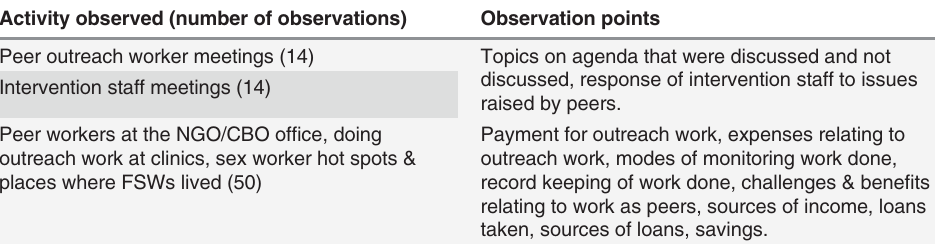
Table 1. Activities observed to understand the work of peer outreach workers in an HIV-prevention intervention for FSWs. Activity observed (number of observations) Observation points Peer outreach worker meetings